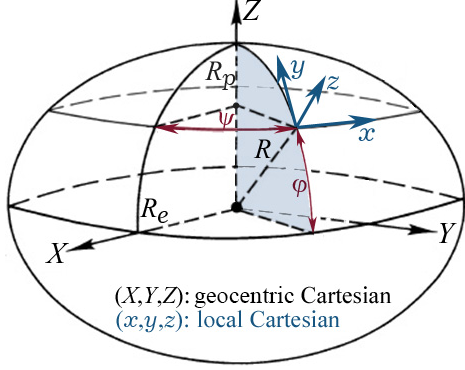
Figure 1. Local and geocentric Cartesian coordinate